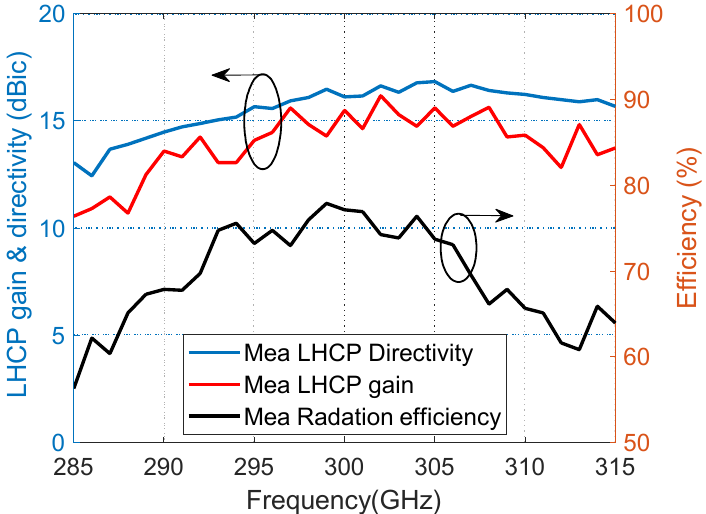
Figure 4. Measured LHCP directivity, realized gain, and radiation efficiency of the proposed an- tenna.